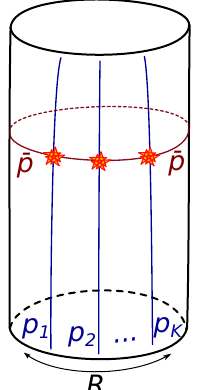
Figure 1 . Pictorial representation of a wrapping e(cid:11)ect. The worldsheet is a cylinder of size R . One mirror particle of mirror momentum (cid:22) p ( u ) (dark red) wraps around it, scattering in sequence with particles 1 ; 2 : : : K (blue). We should sum over all possible mirror particles and integrate over their rapidities u